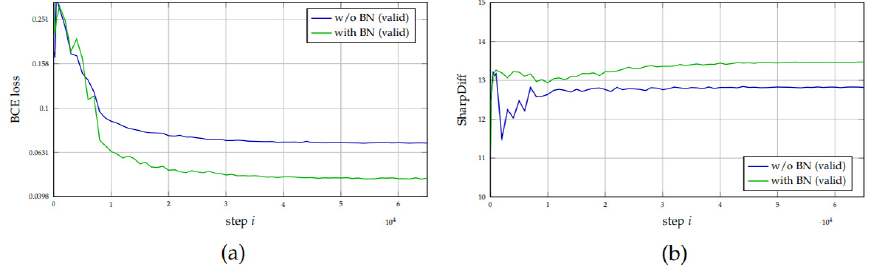
Fig. 10. Comparison of the validation results from two model instances where one uses batch normalization layers in the spatial encoder and decoder